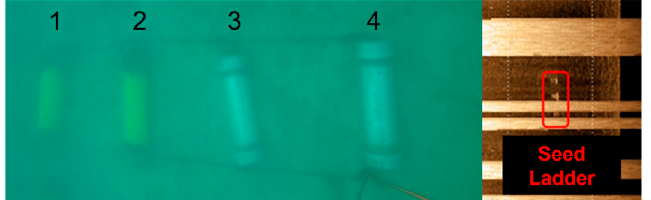
Figure 1. Left: photograph of a deployed ladder of mock UXOs comprised of two acrylonitrile butadiene styrene tubes (1 & 2) and two steel pipes (3 & 4). Right: the resulting image created by a side-scan sonar directly integrated onto an USV without any interference mitigation. The ladder structure is mostly obscured by interference in the sonar image.